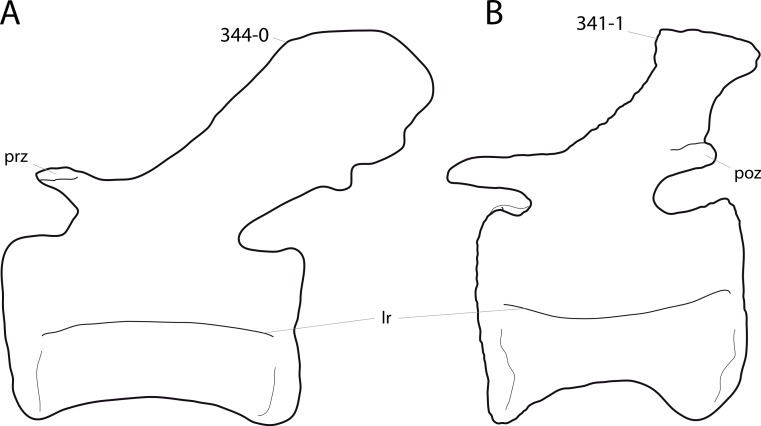
Eusauropod mid-caudal vertebrae.Mid-caudal vertebrae of Cetiosauriscus stewarti NHMUK R.3078 (A; traced from Woodward, 1905) and Supersaurus vivianae WDC DMJ-021 (B; traced from a photo by D Lovelace) in left lateral view, illustrating the anterodorsal projection on the spine top (B; C341-1), and the posteriorly elongated neural spine (A; C344-0). Abb.: lr, lateral ridge; poz, postzygapophysis; prz, prezygapophysis. Scaled to same total vertebral height.